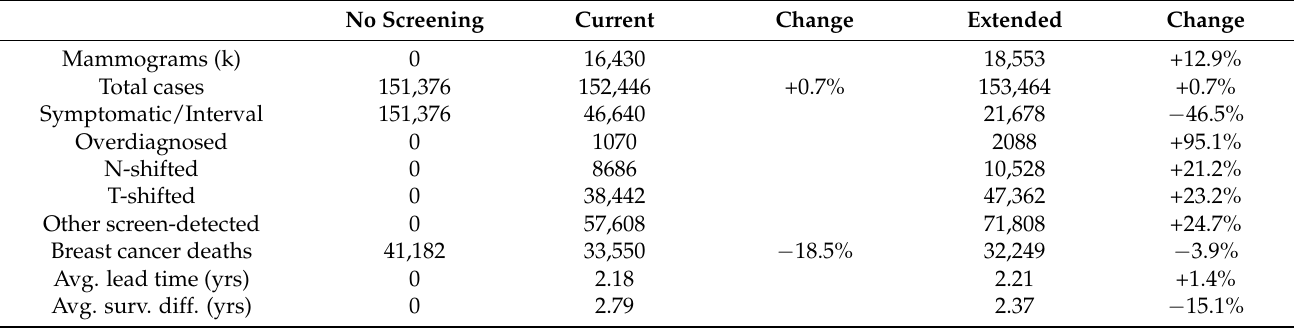
Table 2. Comparison of outcomes between screening programmes—first between current screening (40–74 biennial) and no screening, then between extended screening (40–80 biennial) and current screening. Number of mammograms, cases, and deaths are presented as numbers per million